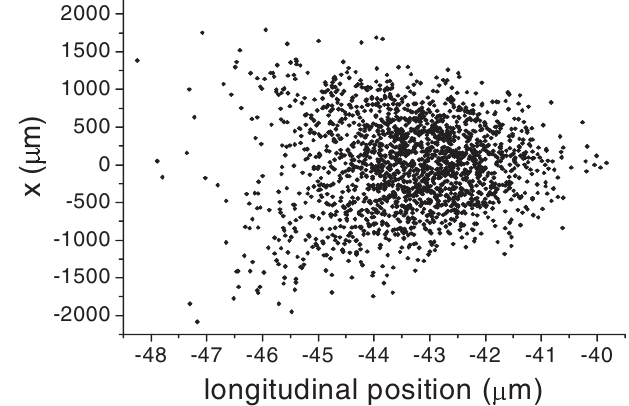
FIG. 7. Femtosecond electron-bunch after 50 cm propagation in a vacuum drift space. The initial bunch parameters are: FWHM duration of 7.5 fs, (cid:7) h (cid:4) i (cid:1) 400 , rms energy spread of 2%.